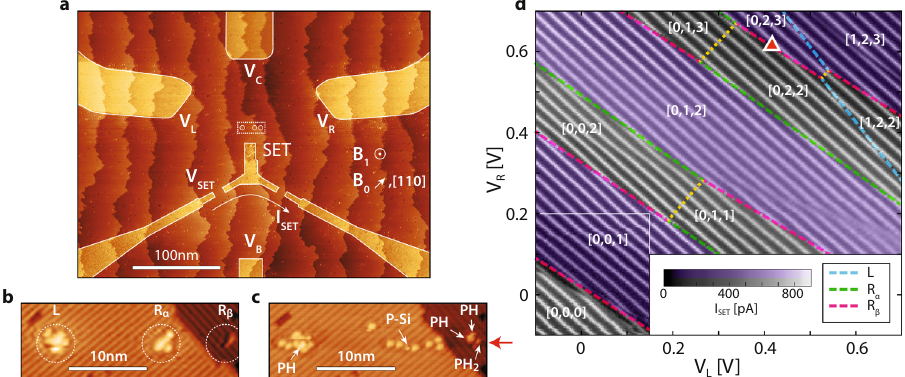
Fig. 1 Charge stability diagram of a single P donor ( L ) and a 1P – 2P molecule ( R α − R β ). a Overview STM micrograph of the device during STM lithography. Bright regions are exposed silicon which are subsequently dosed with phosphine to form conductive leads to the central qubit region (dotted white rectangle). b The central device region before dosing, with three sites ( L , R α , R β ) circled. c The same area following phosphine dosing and imaging. Here additional STM imaging of the surface in the fast (horizontal) scan direction has resulted in the tip un-intentionally creating additional dangling bonds along a scan line (position marked by the red arrow). In the fi nal dosed image surface features containing phosphorus are marked whilst all unmarked bright spots are single dangling bonds incapable of incorporating P atoms. d Measured charge stability diagram of the device, showing I SET as a function of V V V = 750mV, V = 300 mV). Discontinuities represent charge state transitions on the three sites (blue -L , green -R α or pink -R β dashed lines). L and R ( C B Inter-site charge transitions between R α and R β are highlighted in yellow. White numbering gives the electron occupation numbers [ L , R α , R β ]. Spin readout of Zeeman doublet states is only possible within the purple shaded areas. The operating point for the spin control experiments is given by the triangular red